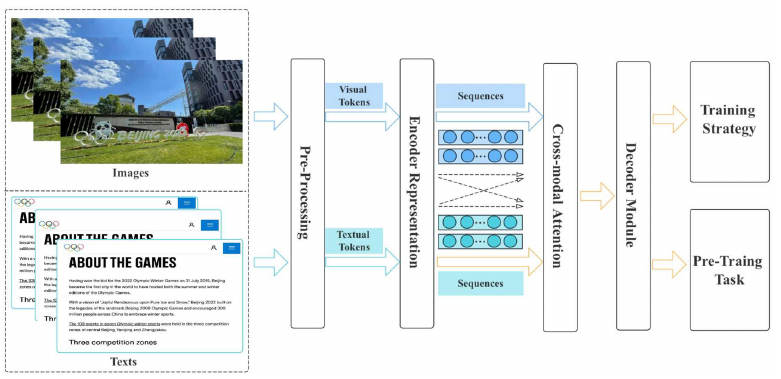
Figure 2. An overview of the cross-modal retrieval